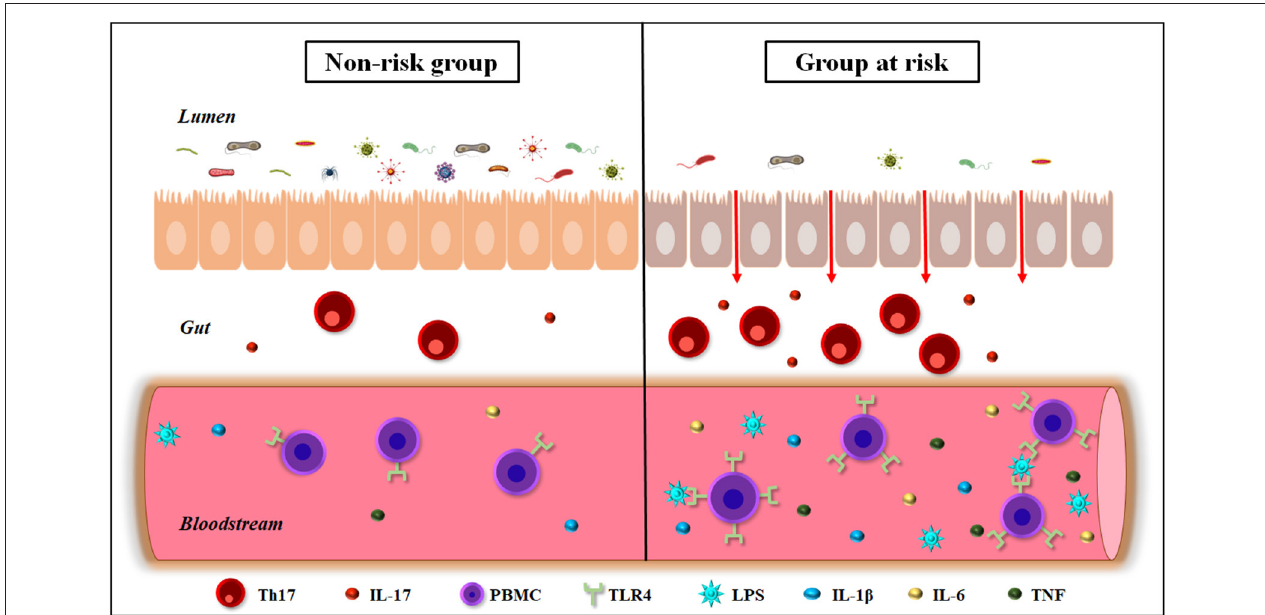
FIGURE 1 | Gut-immune interactions in elderly, diabetic, and hypertensive individuals. These conditions are the three most COVID-19-related death risk factors, and show a decrease in the diversity of the gut microbiota, leading to dysbiosis and weakness of the intestinal barrier permeability. In addition, people belonging to risk groups for COVID-19-related death show hyperimmune activation in the intestine, increasing Th17 + T cells and IL-17 production. These individuals also exhibit a rise in the circulating levels of bacterial endotoxins such as LPS, as well as pro-inflammatory cytokines, as IL-1 β , IL-6, and TNF. Furthermore, the elderly, diabetic, and hypertensive individuals show an increase in the expression of TLR4 in peripheral blood mononuclear cells (PBMCs). IL-17, interleukin-17; IL-1 β , interleukin-1 β ; IL-6, interleukin-6; LPS, lipopolysaccharide; Th17, T helper 17; TLR4, Toll-like receptor 4; TNF, Tumor necrosis factor.